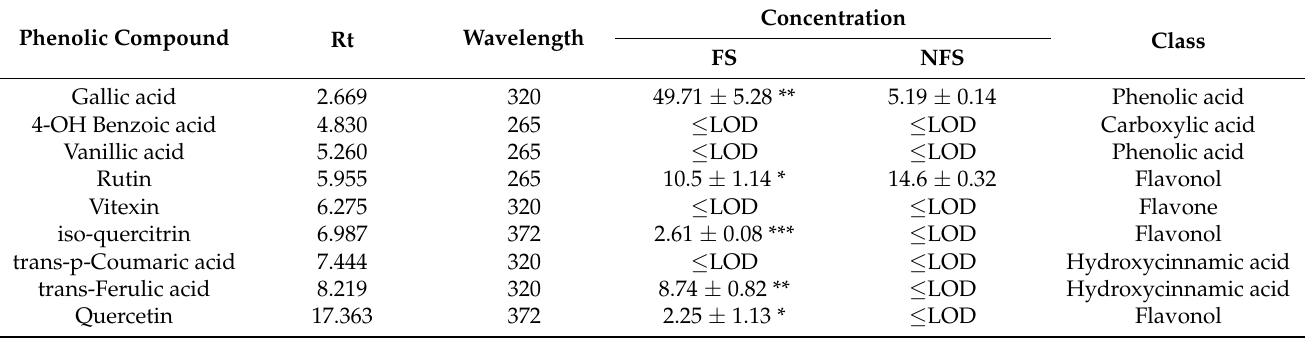
Table 2. Phenolic compounds, class, retention time (Rt, min), wavelengths (nm), and concentrations (mg/kg dw) in the fermented (FS) and non-fermented (NFS) spelt flour. Unpaired Student t -test: * significantly different from NFS: * p < 0.05, ** p < 0.01, *** p <